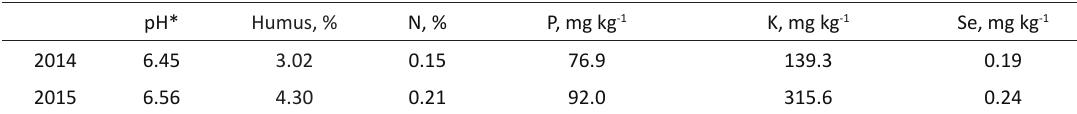
Table 1. Chemical characteristics of the